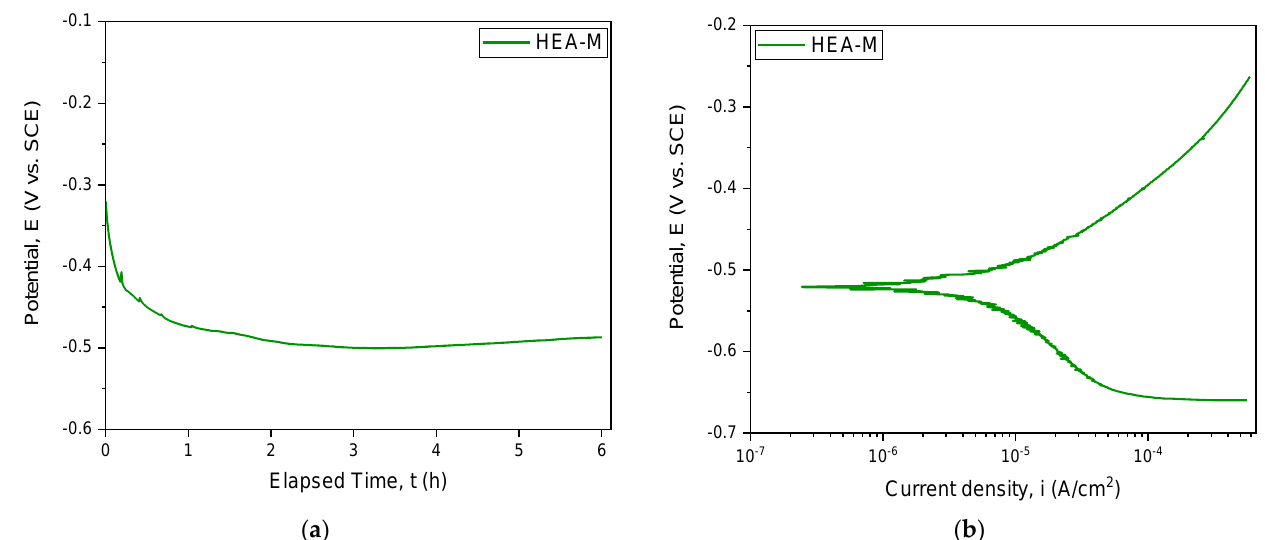
7 of 12 Figure 6. Load chart for pull off testing on CoCrFeNiMo 0.85 high-entropy alloy coating. The load chart presents the elastic behavior and the failure point for the epoxy resin at the maximum load. It can be also observed that the adhesion between the deposited layer and the substrate has better results compared with the layer and epoxy resin adhe- sion, also due to the fact that no cohesive or adhesive failures occurred during the exper- iments.